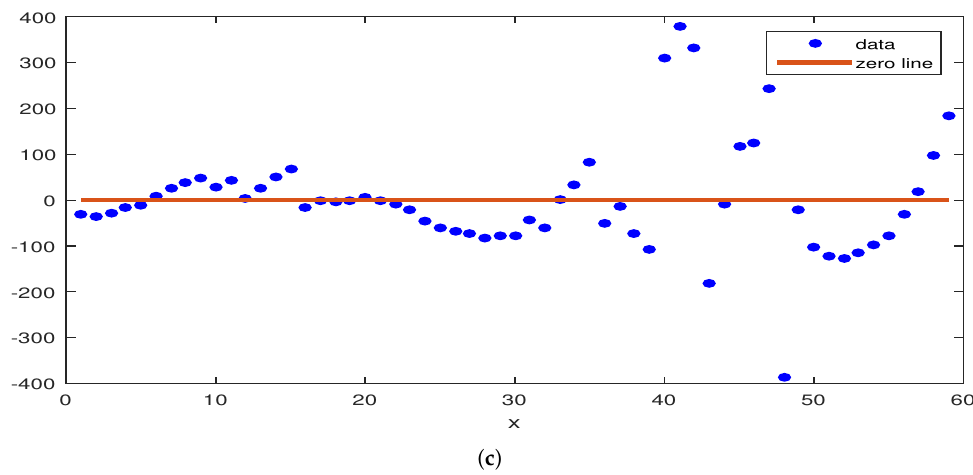
Figure 1. The figure illustrates the profiles of the best-fitted curve and its corresponding residuals for the daily cumulative cases of COVID-19 in Pakistan from 23 Jun 2022 to 23 August 2022. Furthermore, the figures ( a , b ) represent the model fit with reported infected cases and ( c ) represents the residuals. Table 1. The table contains descriptions and estimated values for the